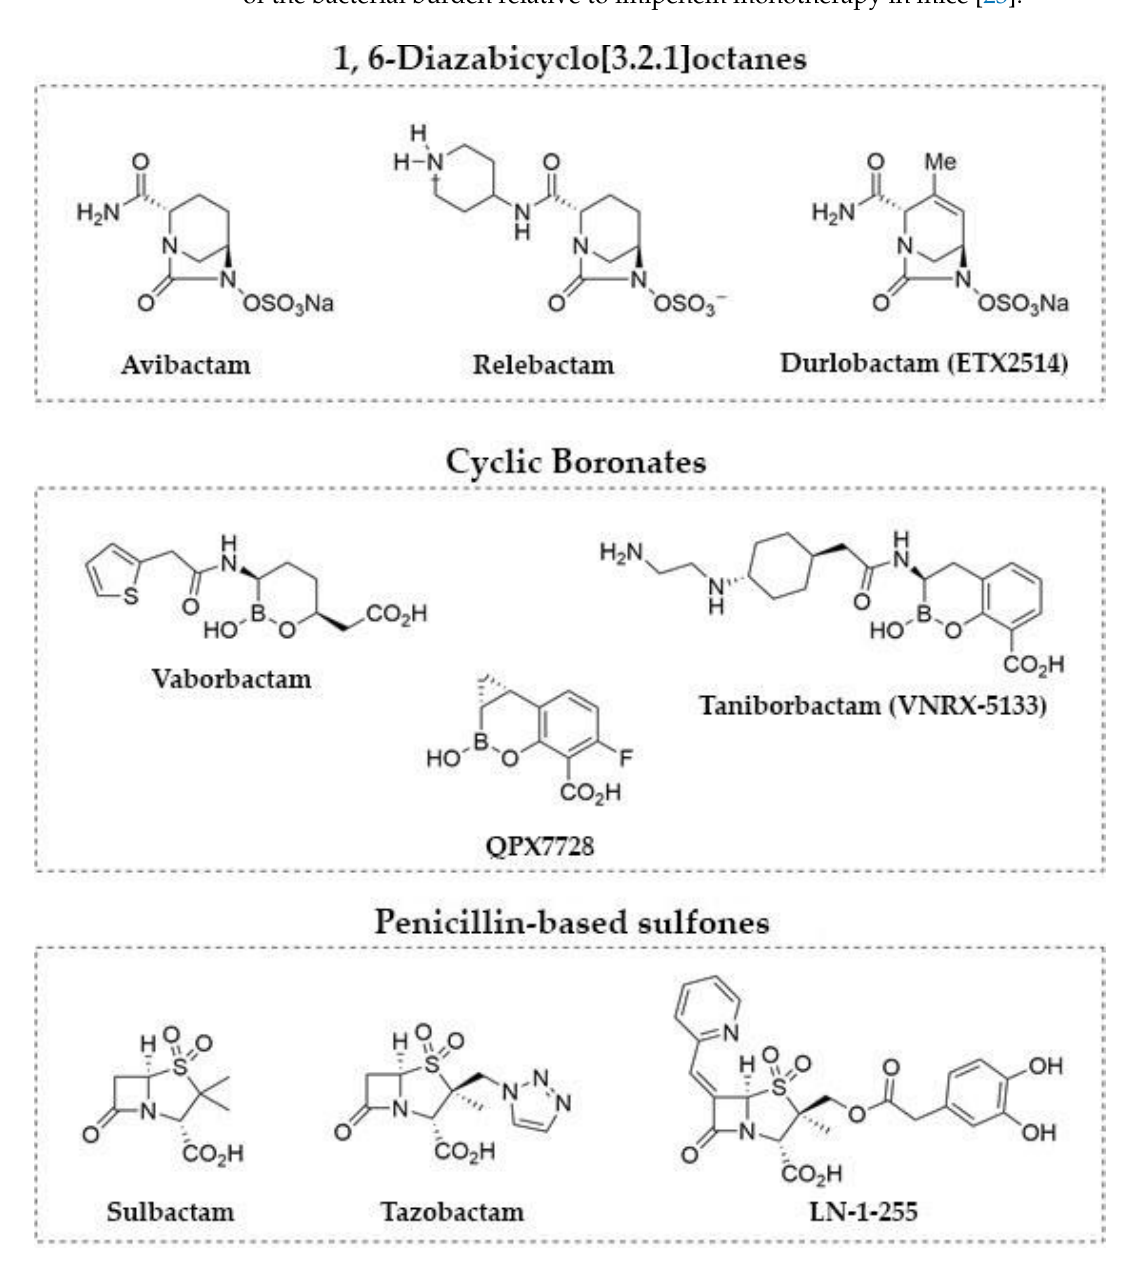
Figure 1. Selected examples of relevant β-lactamase inhibitors.